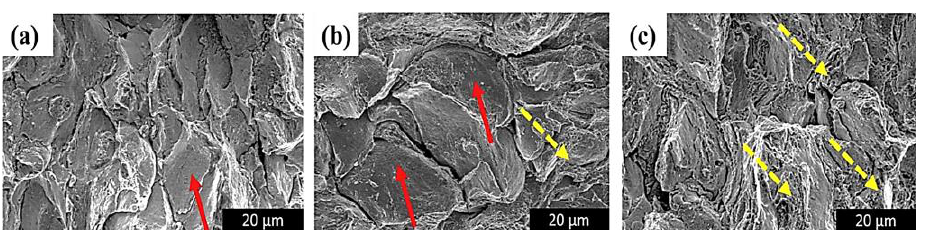
Figure 13. The flexural fracture morphology of ( a ) as-sprayed, ( b ) furnace-heat-treated, and ( c ) local- induction-heat-treated CS IN 718 substrates. The red arrows indicate brittle facets whereas the yellow dash arrows indicate intergranular fractures. Reprinted from Sun et al. [104], Copyright 2019, with permission from Elsevier.